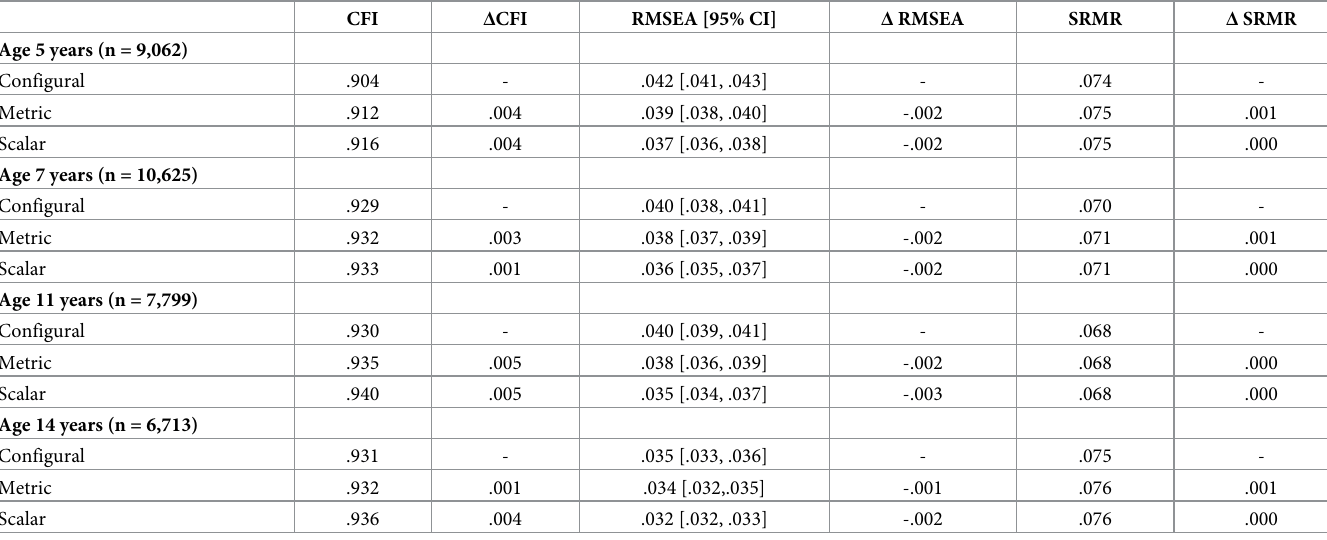
Table 4. Parent highest education measurement invariance models.